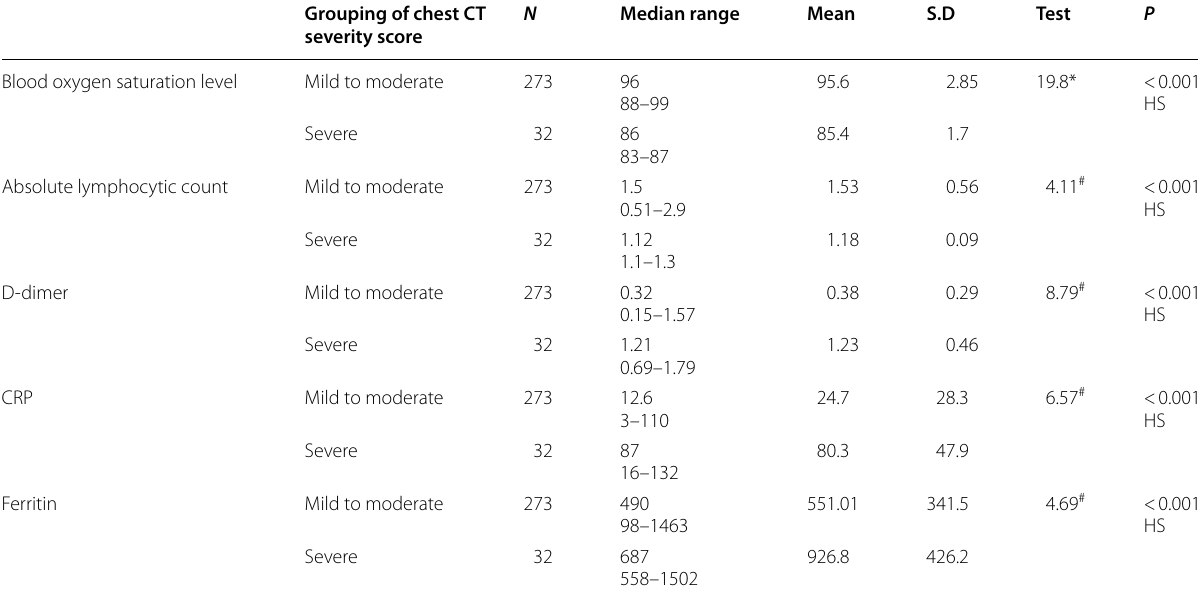
Table 5 Relation between chest CT severity score and laboratory data of the studied cases